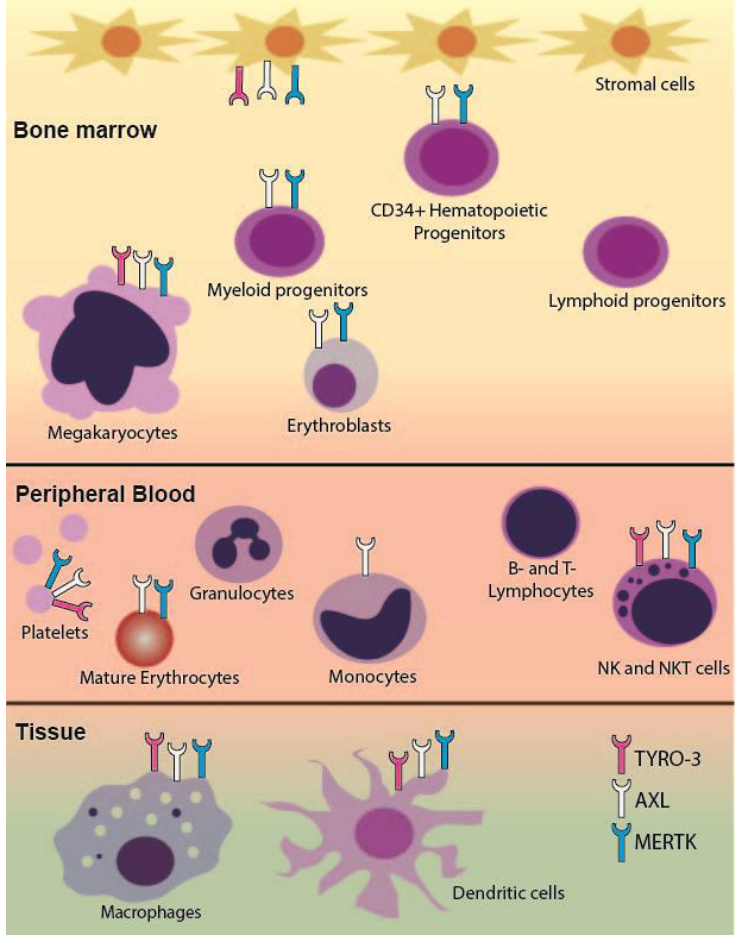
Figure 1. Schematic of TAM receptor expression in hematopoietic cells. Differential expression of TAM receptors in the hematopoietic system is shown. AXL protein and mRNA are expressed in bone marrow stromal cells. MERTK and AXL are expressed in CD34 + hematopoietic progenitors and some stages of myeloid development including erythrocyte precursors in the bone marrow. All TAM receptors are present in megakaryocytes, mature platelets, tissue macrophages, and dendritic cells. MERTK is expressed in bone marrow monocytic precursors and tissue macrophages but not in circulating monocytes. Although TAM receptors are not expressed in lymphoid progenitors or mature lymphocytes, they are highly expressed in NK and NKT cells.